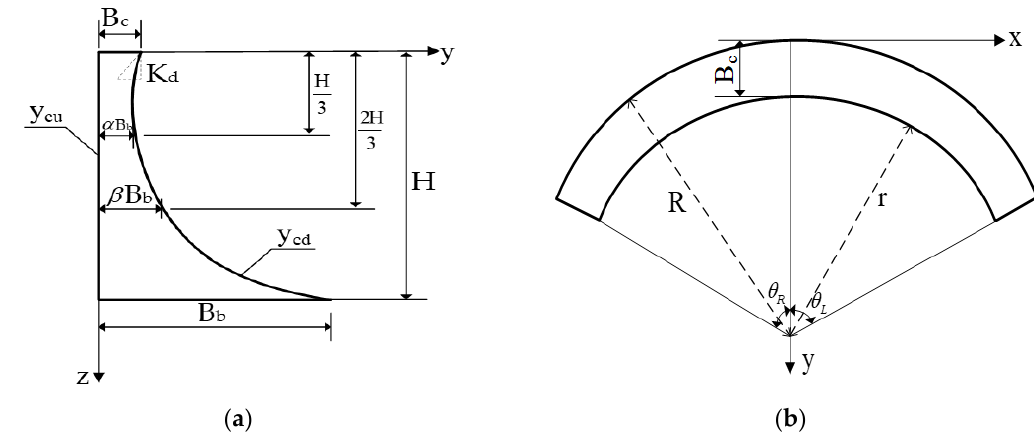
Figure 1. Arch crown cantilever ( a ) and horizontal arch ring ( b ) of a single-curvature arch dam.